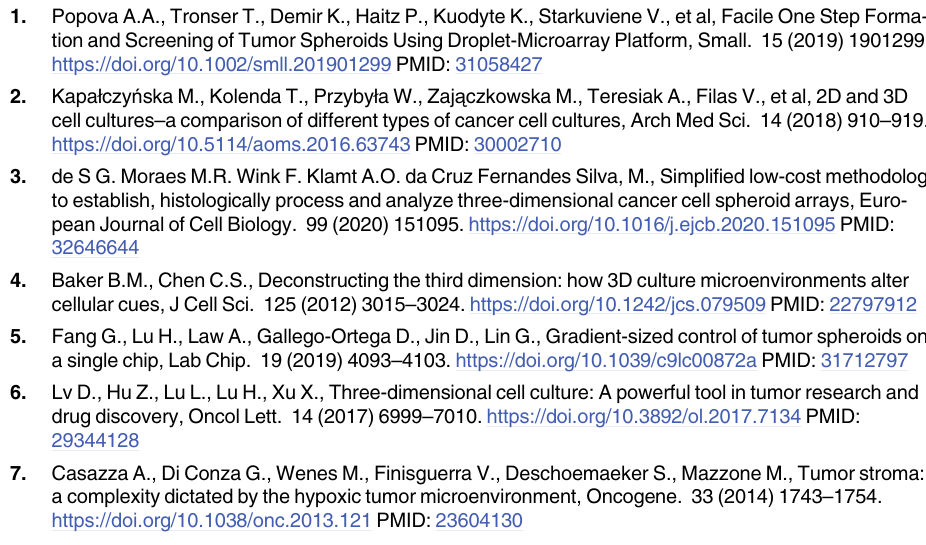
S1 Dataset. W8 raw data. Measurements raw data of mass density, weight, and diameter of live and fix LoVo spheroids treated with crizotinib 250 and 500